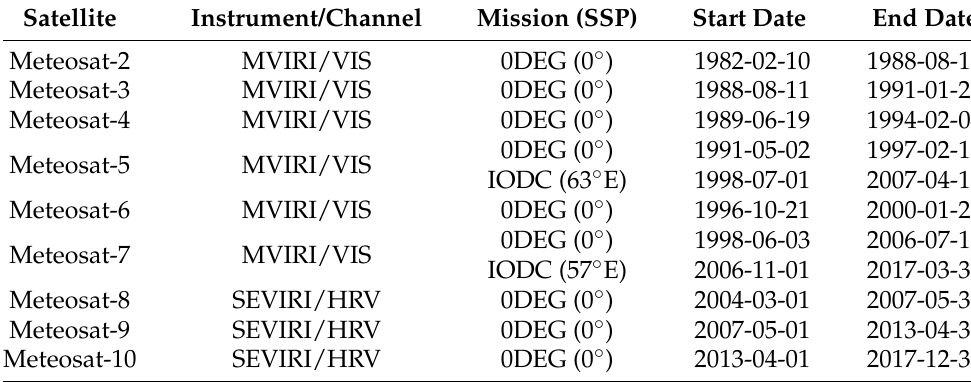
Table 3. Satellite, instrument, mission, nominal orbit position and services for the period 1982– 2017. The period includes Meteosat 2–7 (Meteosat First Generation) and Meteosat 8–10 (Meteosat Second Generation).